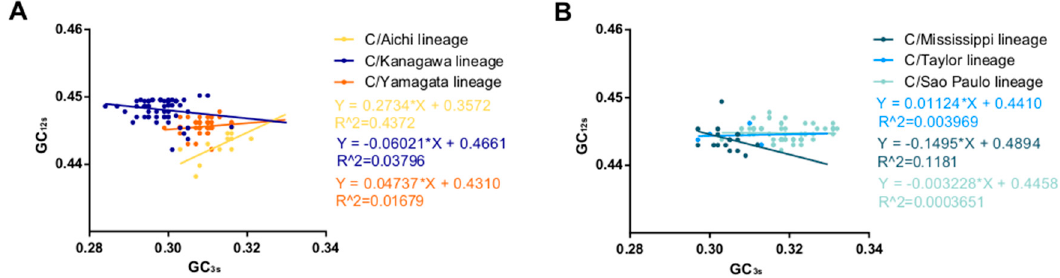
Figure 3. Neutrality analysis of the ICV HE gene. GC 3s are plotted against GC 12s. ( A ) C/Aichi lineage, C/Kanagawa lineage, and C/Yamagata lineage. ( B ) C/Mississippi lineage, C/Taylor lineage, and C/Sao Paulo lineage.